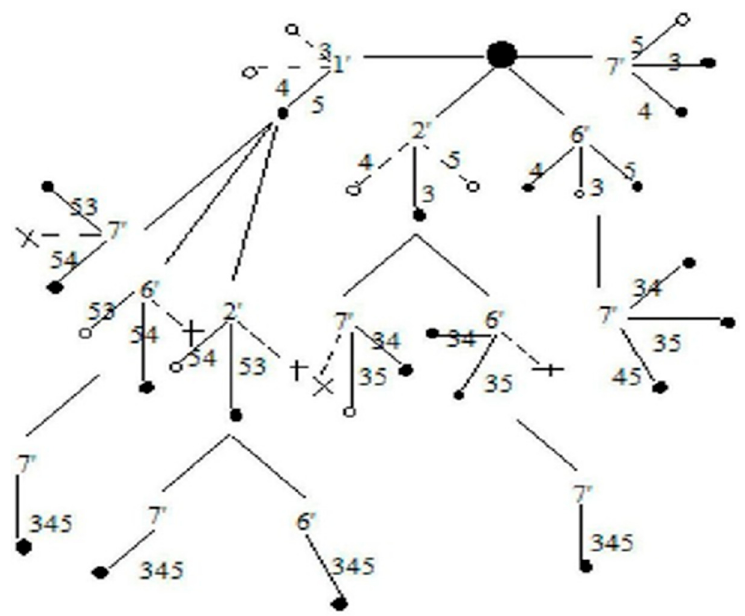
Figure 8. A rooted tree for G (5, 7) . Table 2. Disjoint spanning trees (St i).